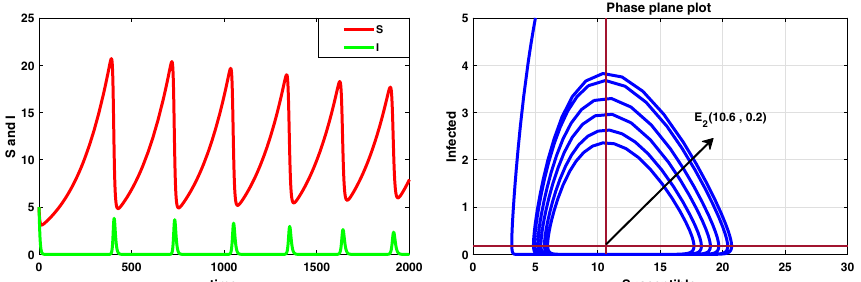
Fig. 5 A dynamical behaviour of system (3) with r > µ and the corresponding two-dimensional phase portrait of S,I with susceptible and infected isocline about endemic equilibrium point E 2 is displayed